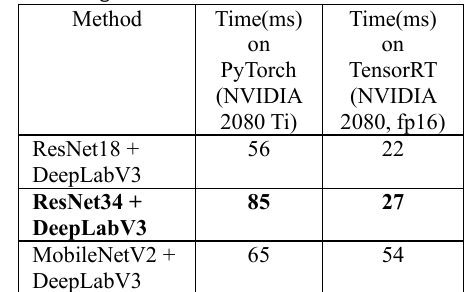
Table 5. Inference time for 1,024×1,024 input on PyTorch and NVIDIA